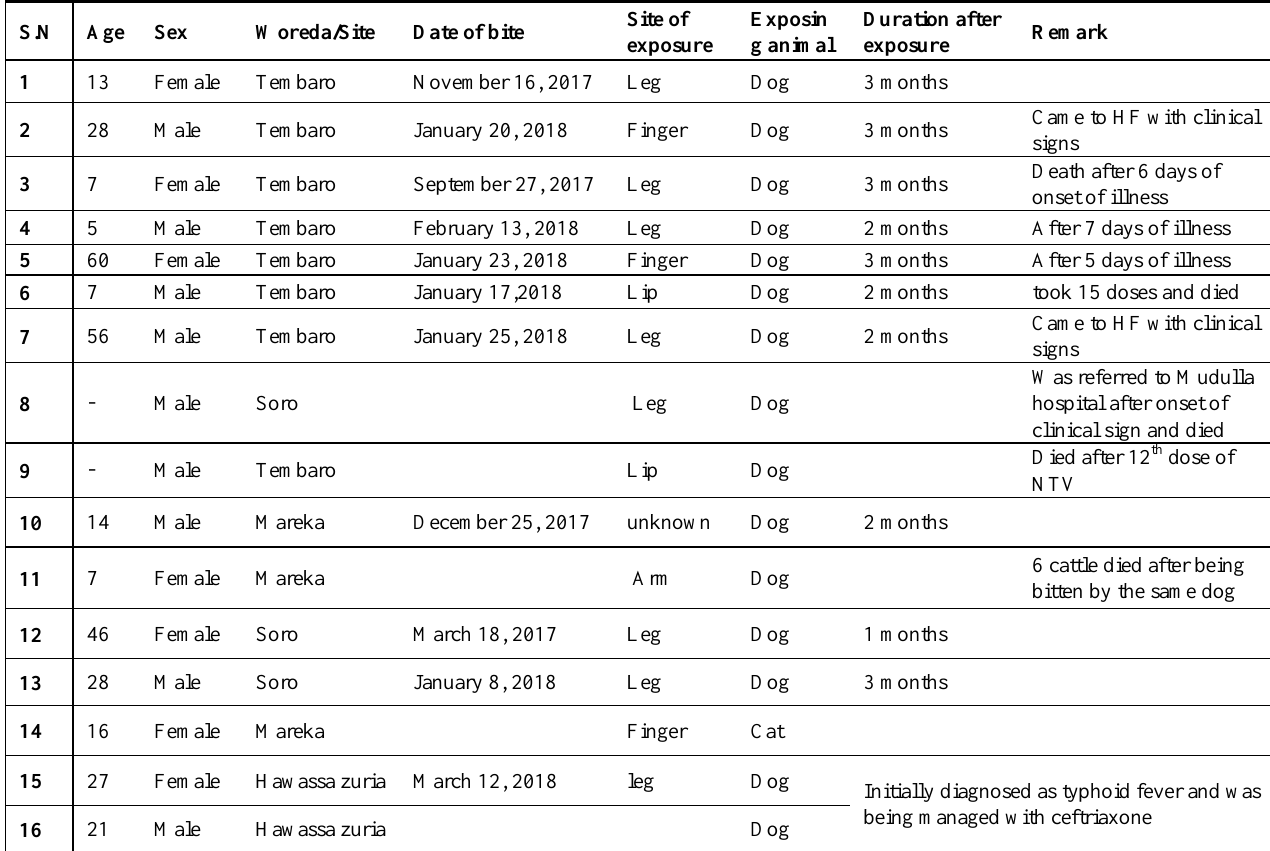
Table 1. Suspected fatal human rabies case scenario from investigation sites of SNNP, Ethiopia. S.N